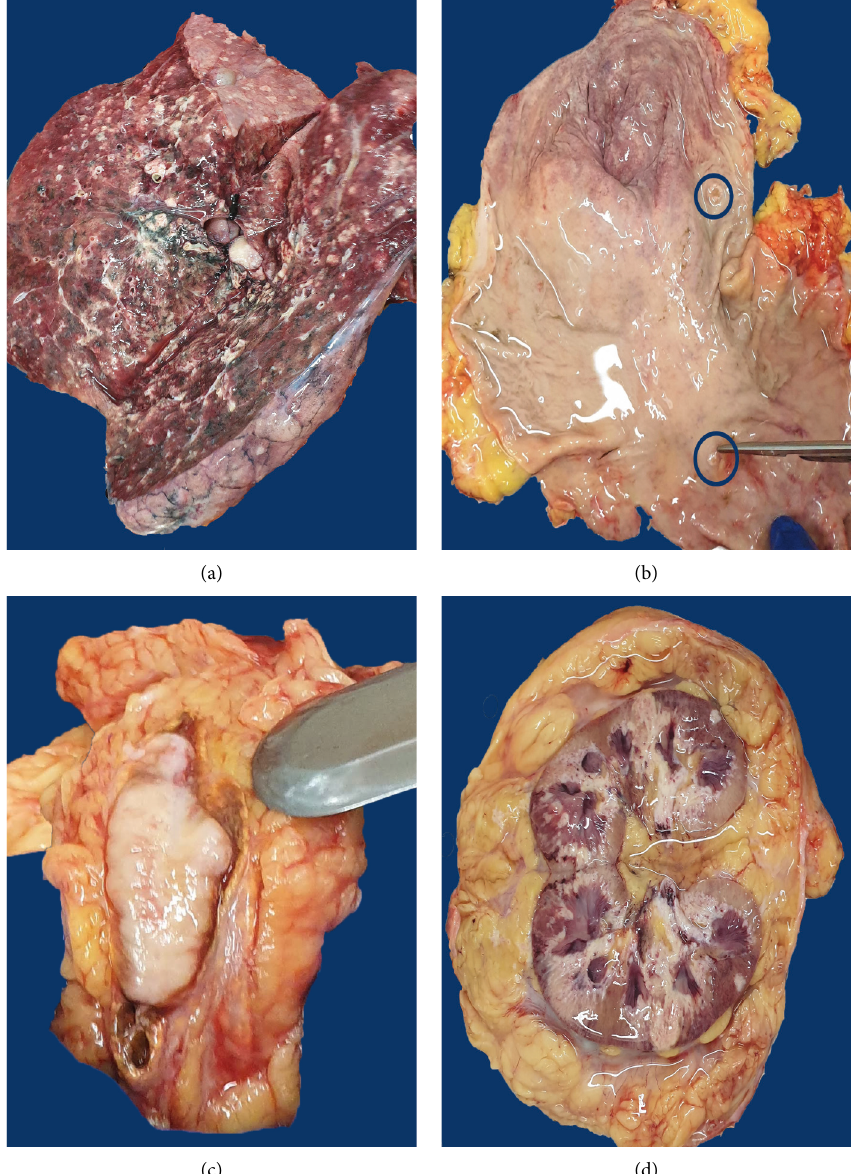
Figure 2: Gross findings of the autopsy specimens: (a) 4 × 3 cm poorly defined lesion in contact with the pulmonary hilum, and multiple foci of necrotic nodules, localized in the right lung. (b) Gross view of the gastric mucosa with one ulcerative, infiltrative lesion. (c) Whitish- yellow, poorly defined lesion in the right adrenal gland. (d) Left kidney showing a surface of cut section with multiple poorly defined lesions with diffuse